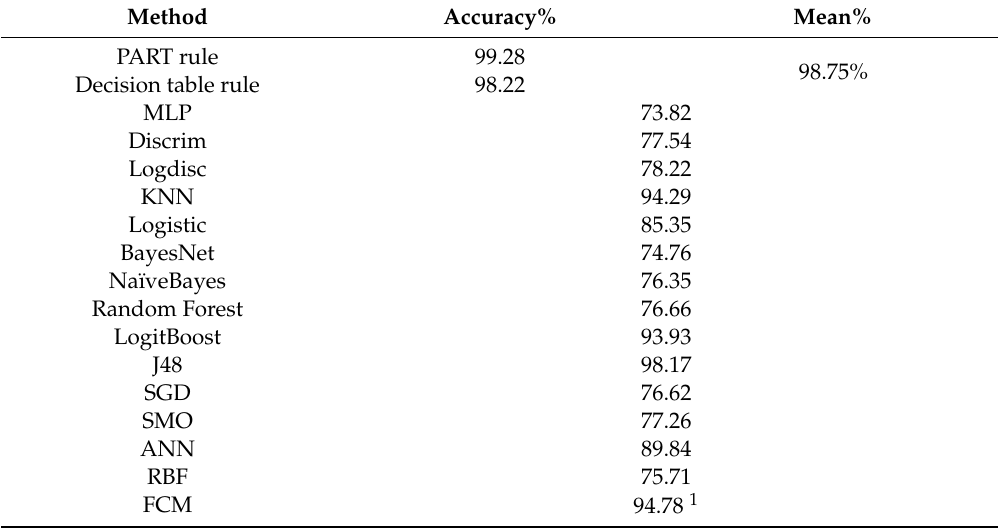
Table 3. The rule classification average precision is compared to other machine learning classifiers based on the same